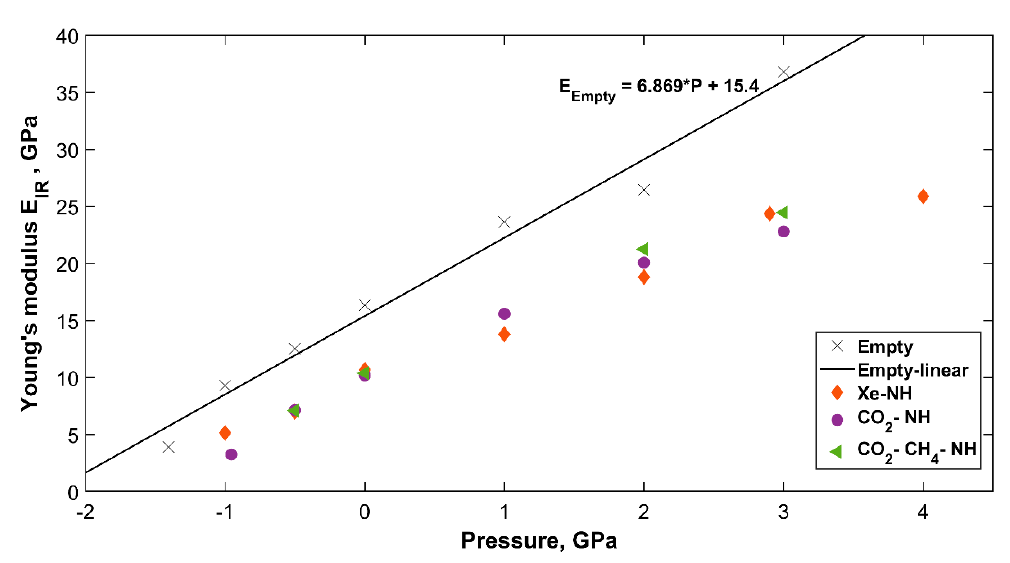
Figure 7. IR computed sH hydrate’s Young’s modulus as a function of pressure.